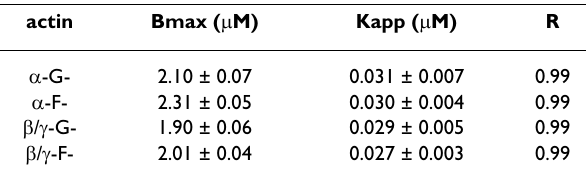
Table 1: Biochemical Binding Parameters from Solid Phase